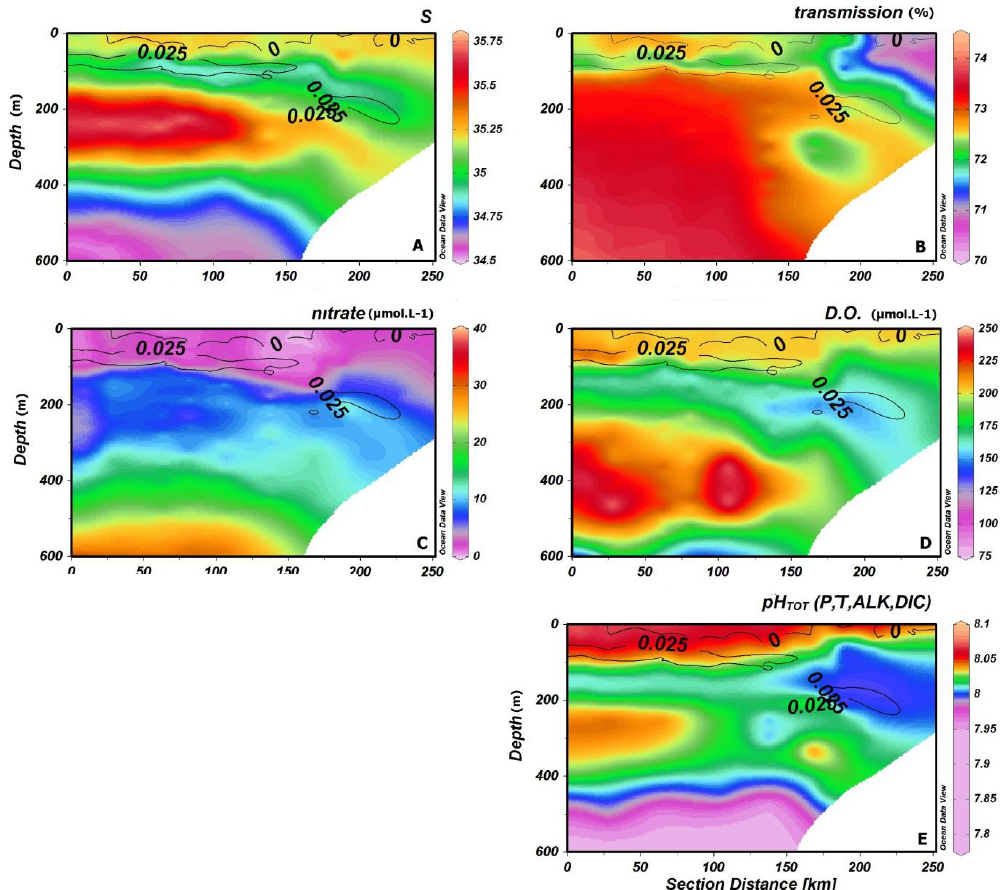
◦ S transect: (A) salinity with major water masses (LC, Leeuwin Current; EGC, Eastern Figure 2 494 Fig. 2. (A–E) Longitudinal depth profiles along 21 Gyral Current; STW, subtropical water). Black contour lines in all panels represent the in situ density interface as the first derivative of density with depth ( d /d zρ) , whose maximum occurs at 1ρ = 0.025kgm − 3 . (B) % transmission, with a path length of 25cm at 660nm (lower values indicate higher particle concentrations); (C) nitrate concentrations in µmolL − 1 ; (D) dissolved Oxygen concentrations in µmolL − 1 ; black arrow indicating low oxygen layer; and (E) pH, derived from total alkalinity and dissolved inorganic